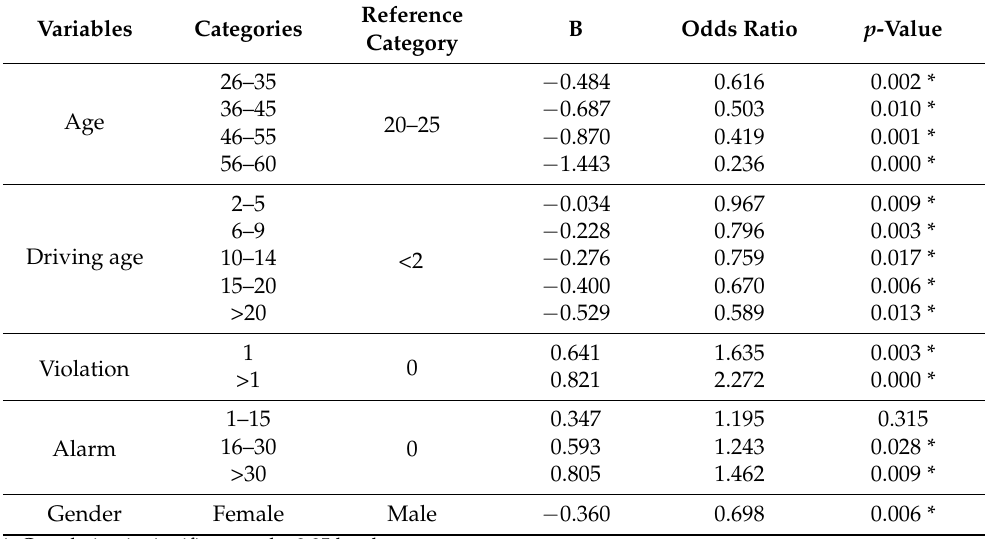
Table 14. Binary logistic regression parameter estimates and odds